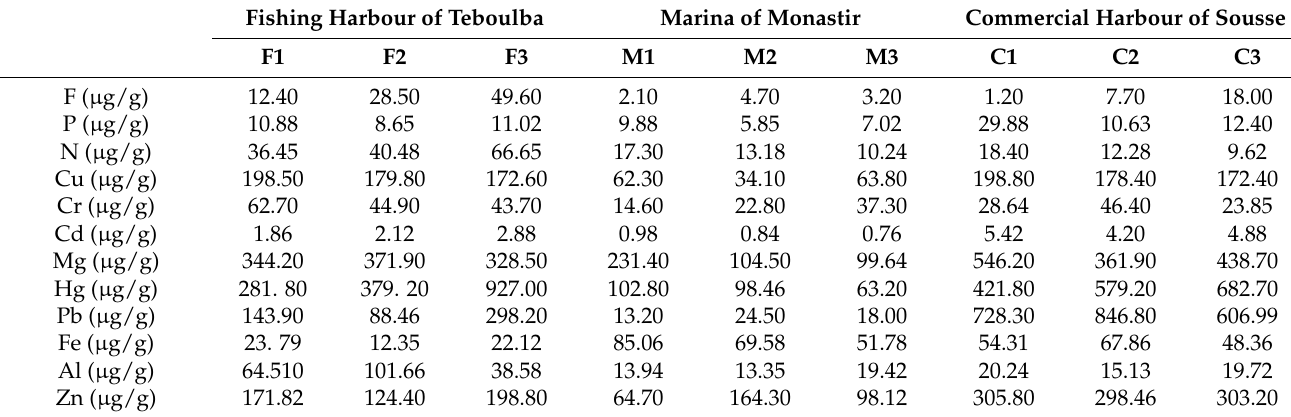
Table 2. Pollutant concentrations in surface sediments of the stations sampled in the three harbours in spring